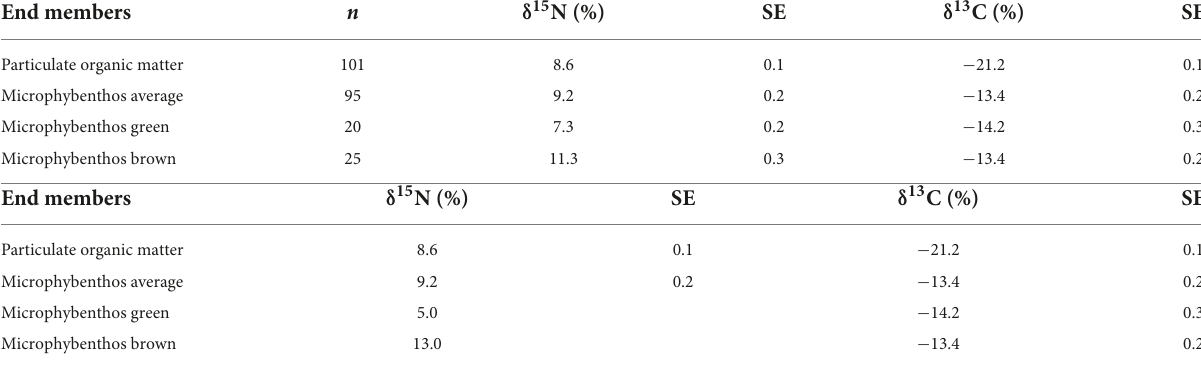
TABLE 2 Bulk δ 15 N and δ 13 C values for the end member values supporting the Dutch Wadden Sea benthic food web used for two and three source mixing models on species means. End members n δ 15 N (%) SE δ 13 C (%) SE